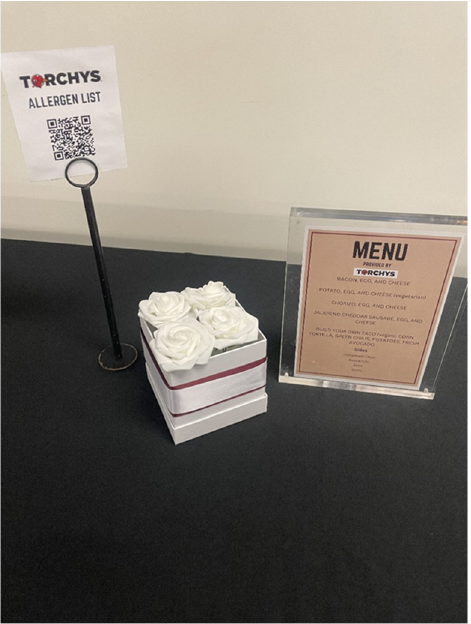
Figure 9. Flower boxes made of recycled cardboard and planned for reuse (Source: D.L. Sullins).